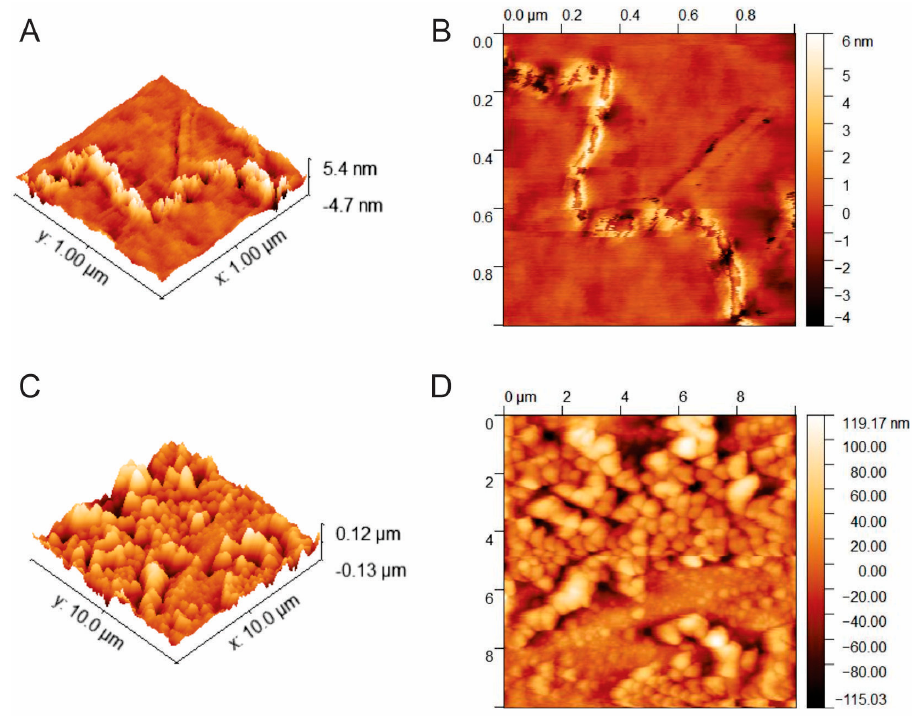
Figure 1. Morphological analysis of whey fibrils compared with β -lactoglobulin fibrils by AFM. ( A ) 3D reconstruction of AFM image of β -lactoglobulin fibrils; ( B ) image of morphology of β -lactoglobulin fibrils; ( C ) 3D reconstruction of AFM image of whey protein aggregates; ( D ) image of morphology of whey protein aggregates.